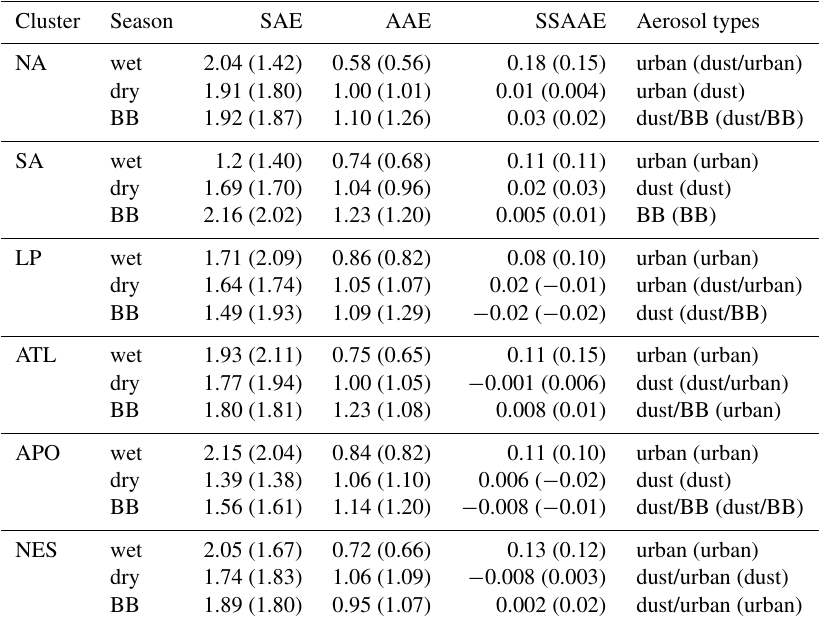
Table 2. Median aerosol Ångström exponents of turbulent conditions (stable conditions) for each cluster and season measured at the CHC station along with the resulting aerosol